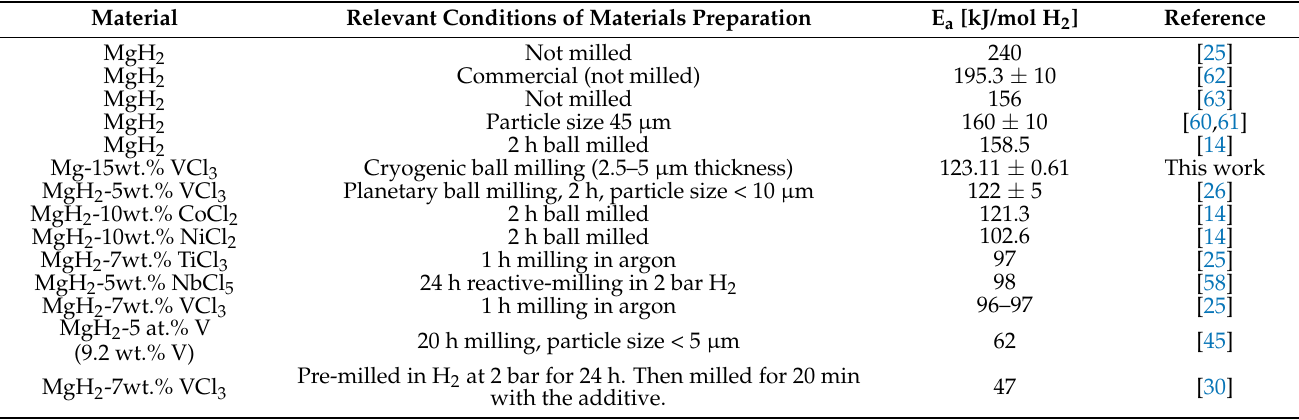
Table 5. Activation energy of dehydriding